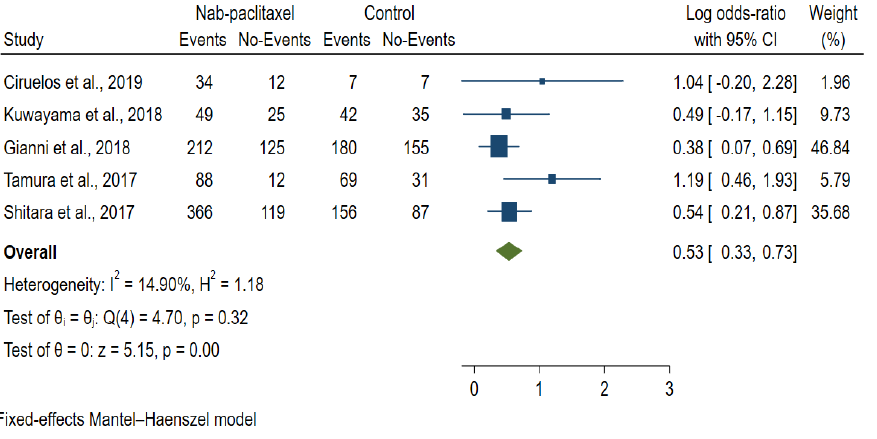
Fig. 5. The forest plot showed the odds ratio of Neurotoxicity-specific.